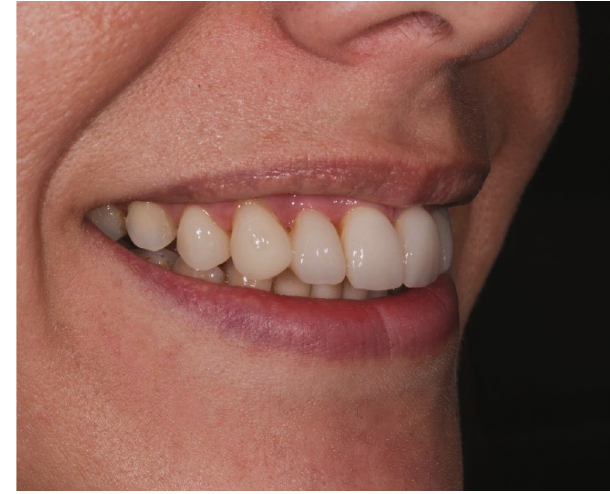
Figure 14: Clinical case: 3/4 view, at the end of the